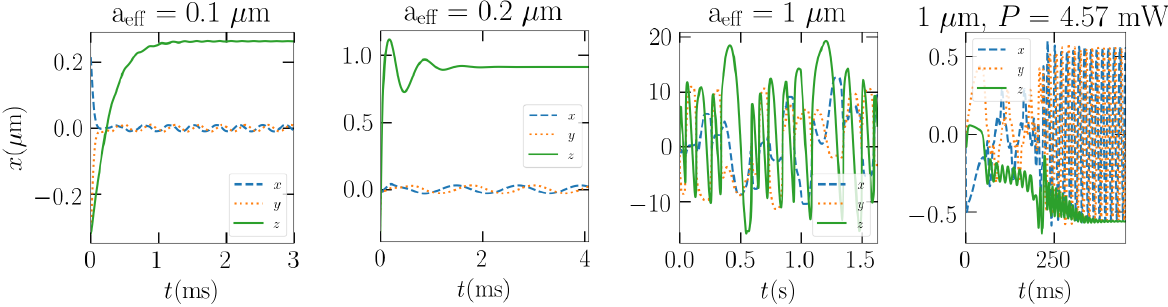
Fig 7. From left to right: The positions of the a = 0.1, 0.2, and 1 μ m Gaussian ellipsoids in air as a function of time in the LG 00 optical trap. The first 3 panels correspond to beam power 230 mW, and the last panel to 4.57